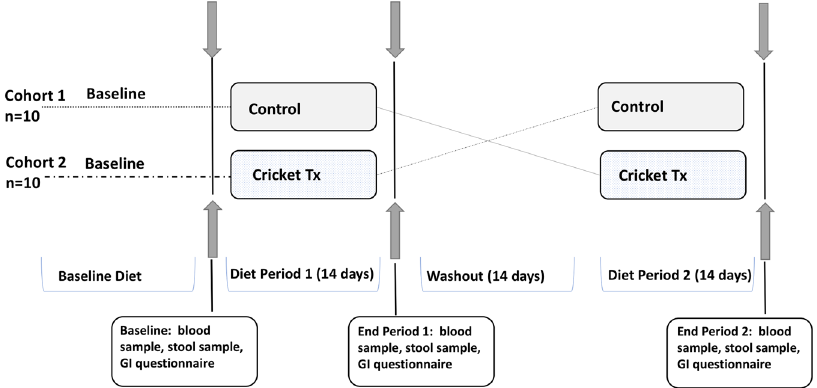
Figure 1. Study design. Cricket Tx = Breakfast with 25 g Cricket Powder; Control = Breakfast without Cricket